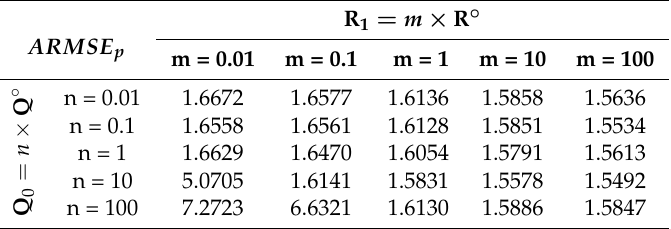
Table 2. ARMSE p results of AUKF-window (windowsize = 10).